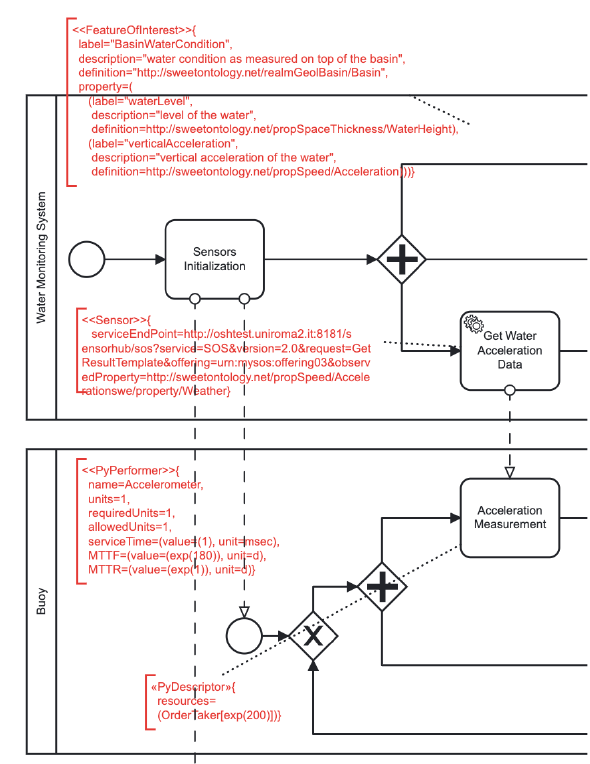
Figure 11. Annotation of the BPMN model with performance- and IoT-related properties